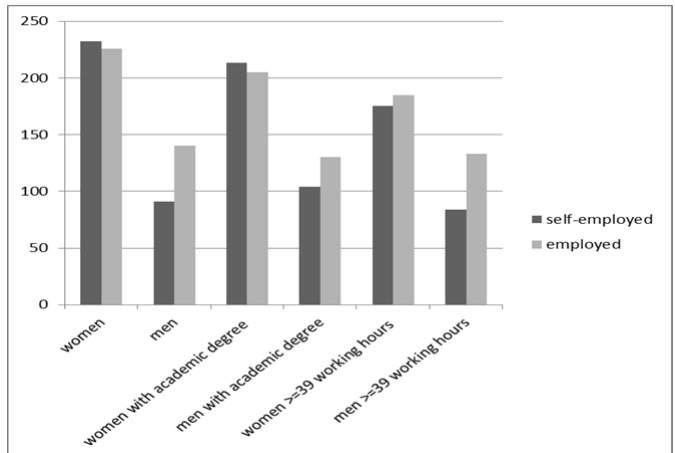
Figure 1 : Minutes used for housework by employment